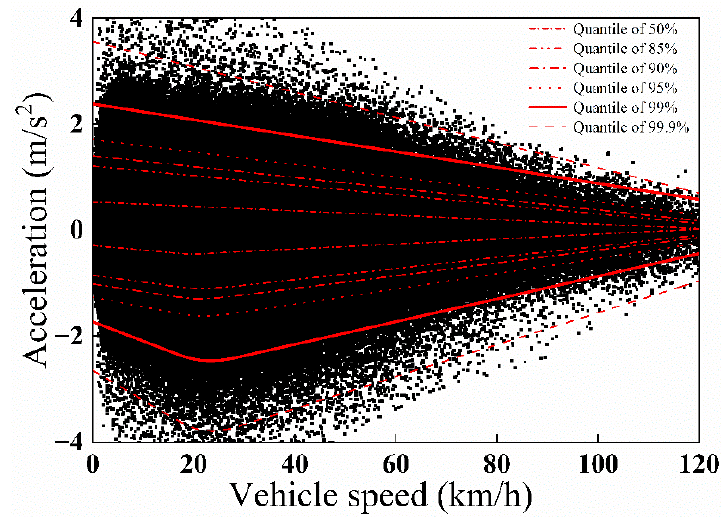
Figure 12. The linear result of quantile for acceleration and deceleration.